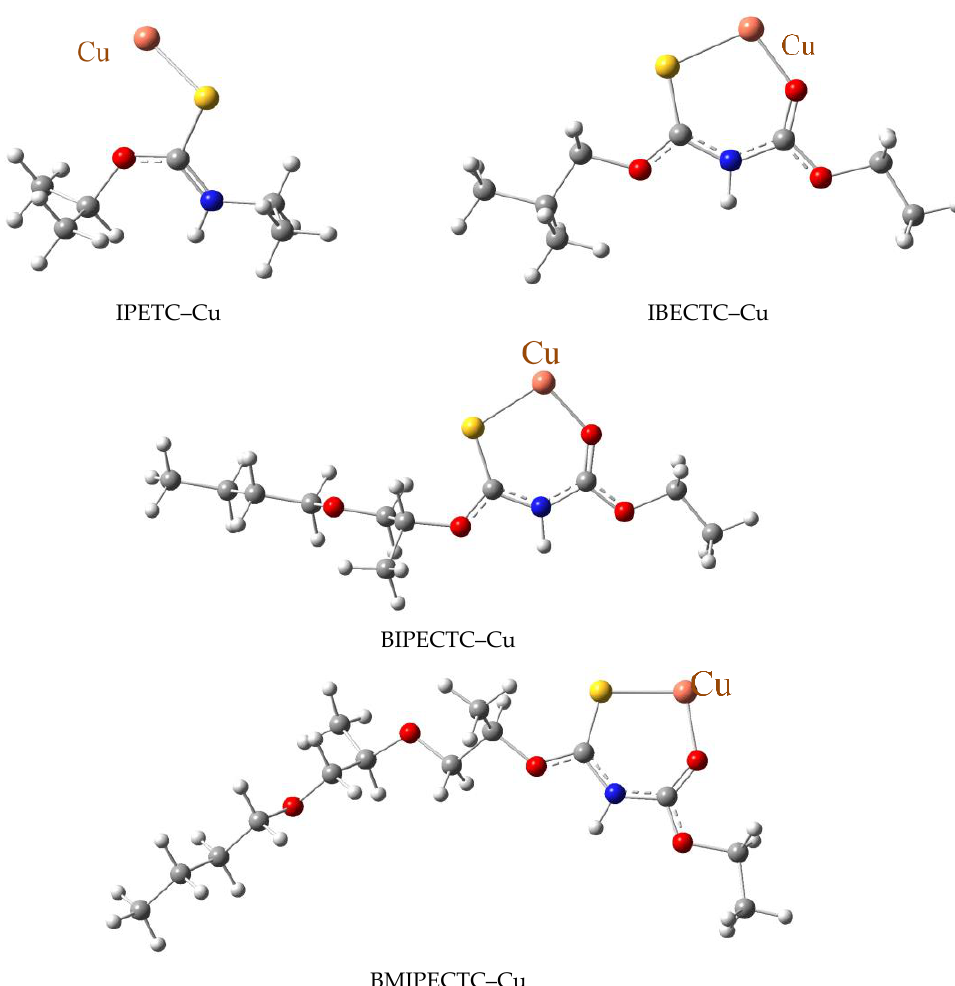
Figure 14. The binding model between copper ion and BIPECTC, BMIPECTC and IPETC.